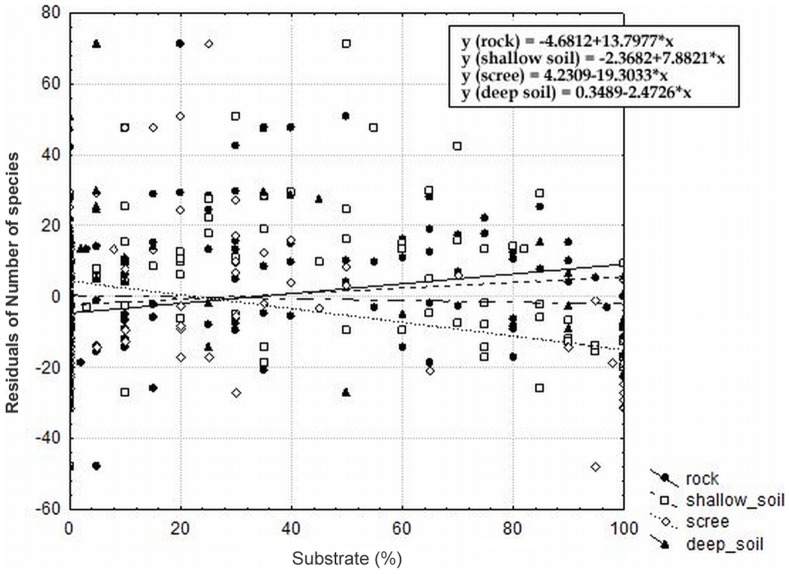
The effect of the substrate on species richness.The effect of the substrate in sense of the proportion of different types of substrate (rock, shallow soil, scree and deeper soil) on species richness (depicted as residuals of number of species with coordinates as covariates). P = 0.0054; r = 0.245 for rock, p = 0.154; r = 0.128 for shallow soil, p = 0.0003; r = −0.314 for scree and p = 0.6813; r = −0.037 for deeper soil.